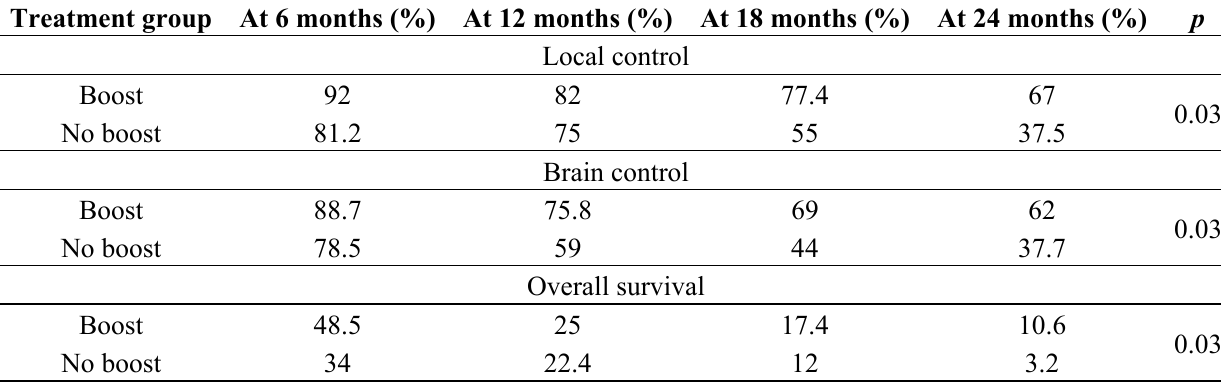
Table 1. Local control and brain control results, as well as overall survival of recursive partitioning analysis (RPA) II patients with 1 or 2 brain metastases (BM) treated with whole brain radiation therapy (WBRT) and with or without